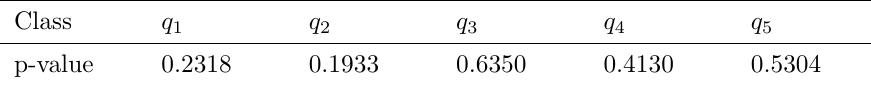
Difference-of-means test’s p-values on 2006-2008 versus